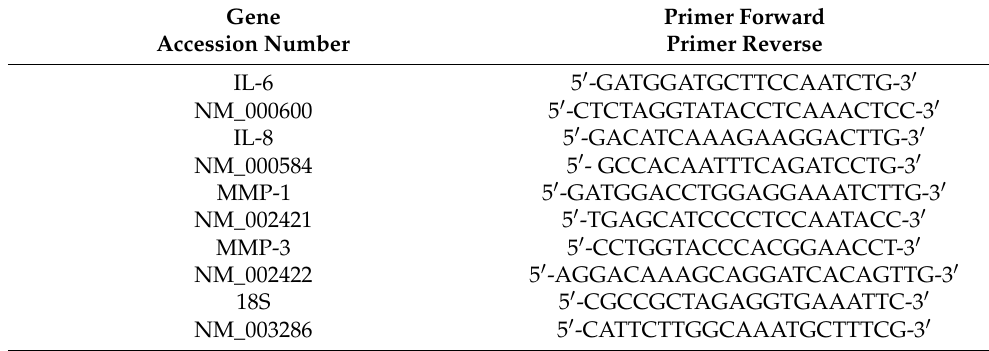
Table 1. RT-PCR primer